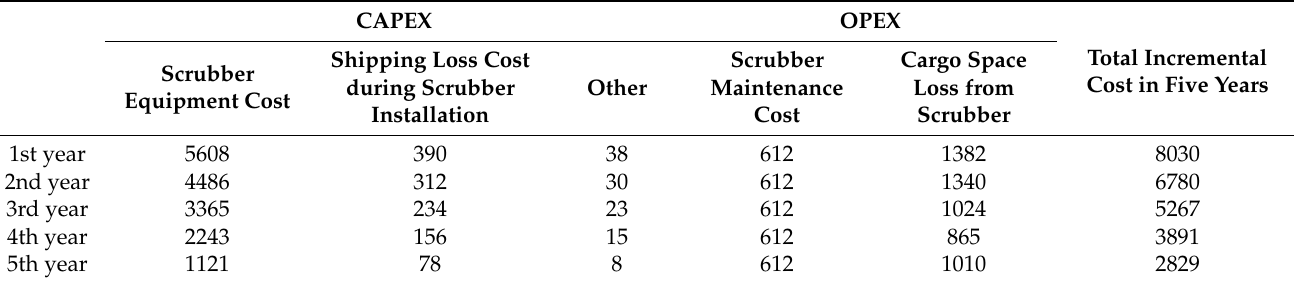
Table 7. Total incremental cost after Strategy Scrubber is implemented unit: